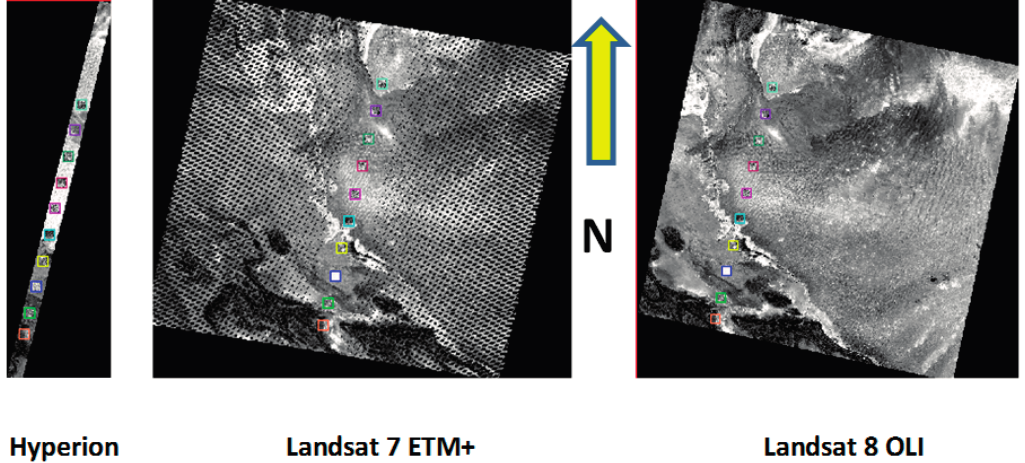
Figure 3. Hyperion, ETM+ and OLI images over path 198, row 39 acquired during the L8 underfly on 30 March 2013. 10 ROIs each of approximately 6 km by 6 km area were chosen from geo-registered L1T products. The co-ordinates of the ROIs are provided in Table